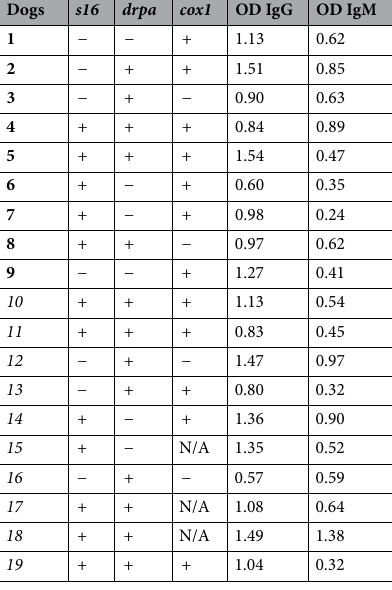
Table 1. Amplification pattern of targeted D. repens specific cfDNA fragments and OD values obtained in DrSA ELISA in microfilaremic (italic) and amicrofilaremic (bold) dogs. “ + ” detected; “ − ” not detected; “N/A” not